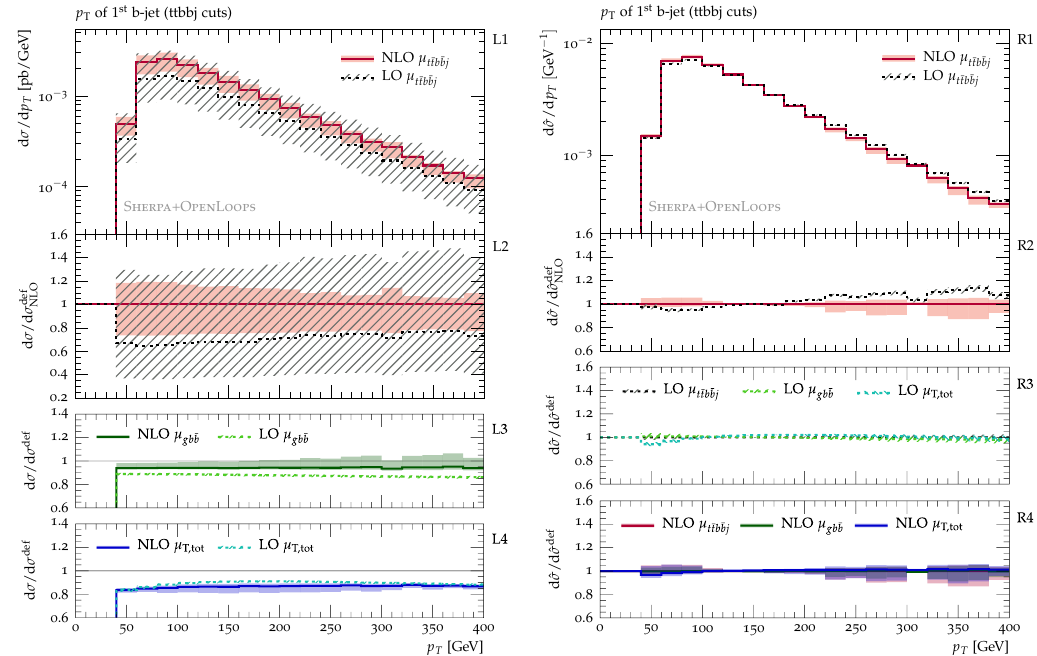
Figure 13. p T of the (cid:12)rst b -jet. Same setup and plots as in (cid:12)gure 8.